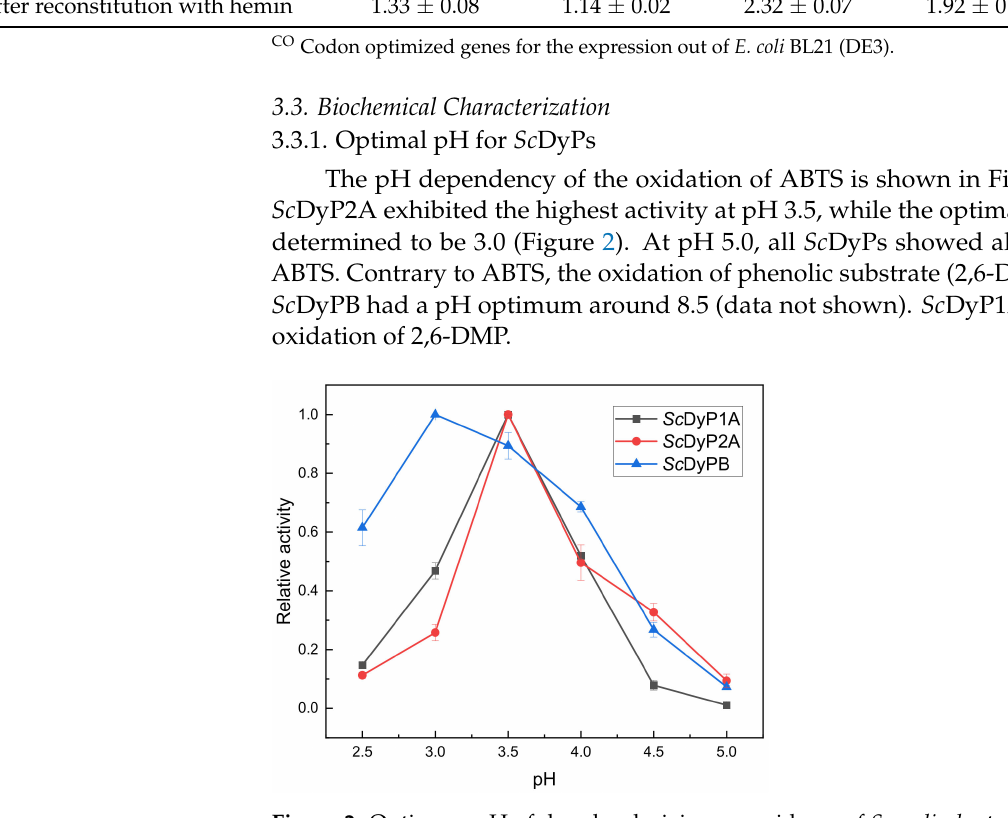
Figure 2. Optimum pH of dye-decolorizing peroxidases of S. coelicolor toward oxidation of ABTS. Data are average values of three independent